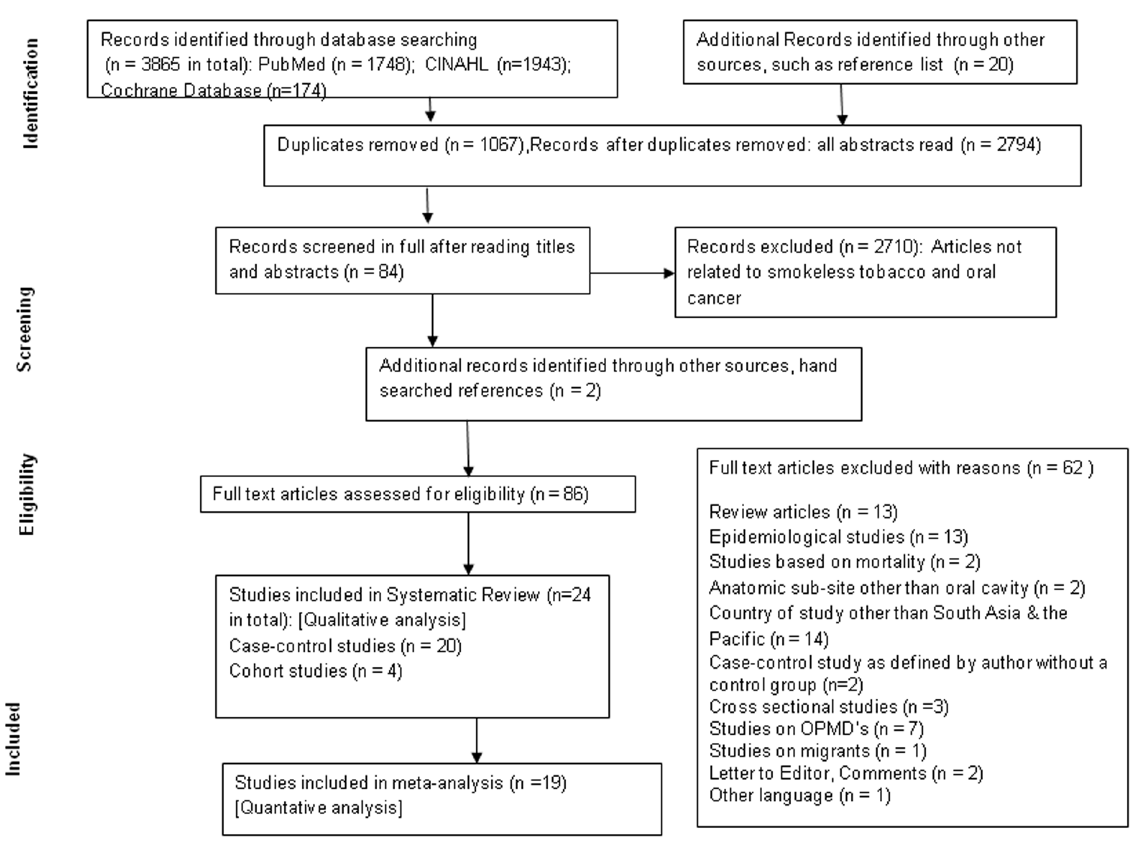
Figure 1. PRISMA strategy for Systematic review and meta-analysis of association of ST and BQ without tobacco with incidence of oral cancer in South Asia and the Pacific.